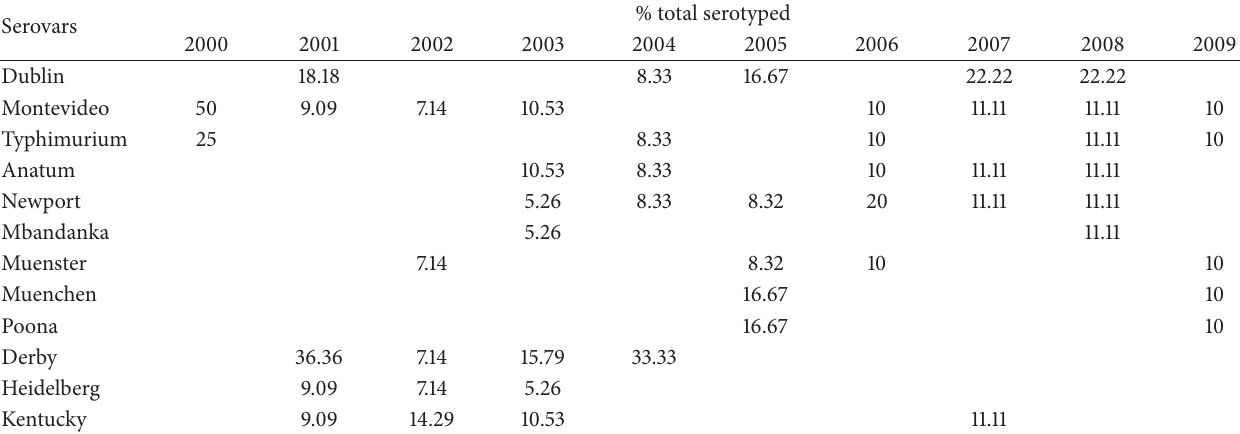
Table 11: Examples of Salmonella serovars profiles from steers and heifers in the US [36]. Serovars